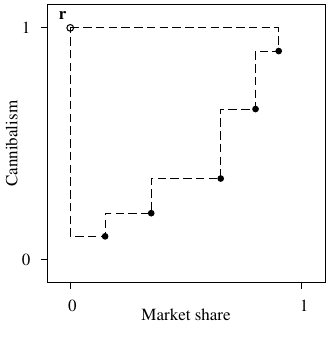
Figure 5. Illustration of the hyper-volume